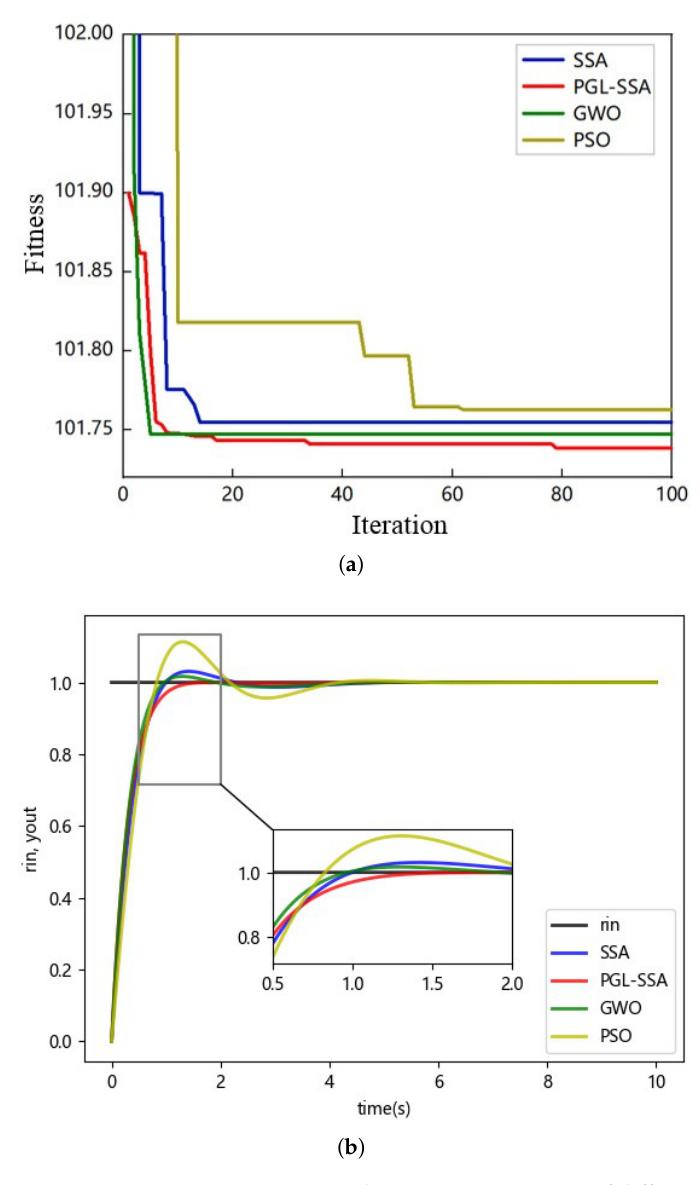
Figure 11. Convergence curves and step response curves of different algorithms for second-order inertial delay systems. ( a ) Convergence curve. ( b ) step response